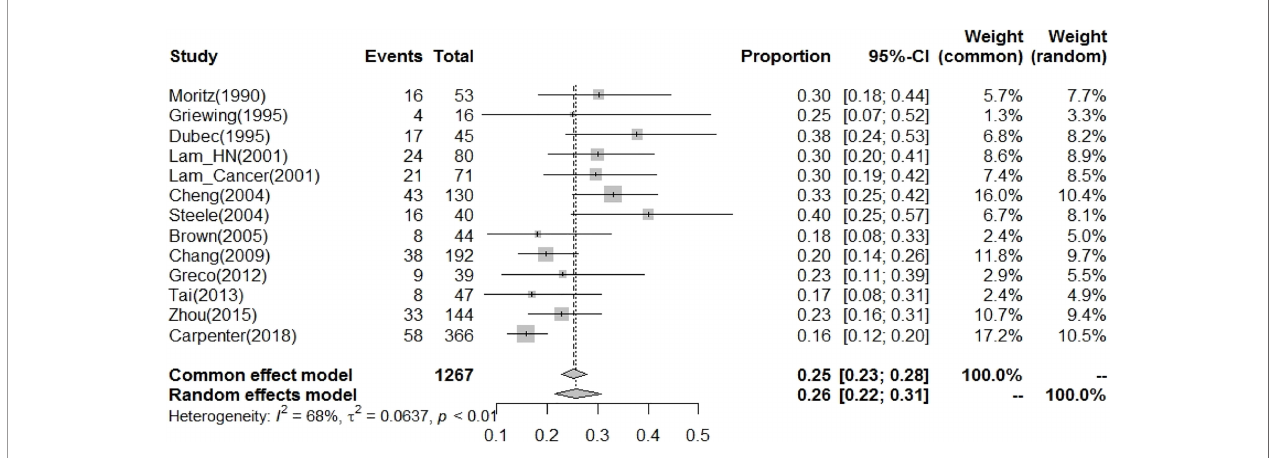
FIGURE 4 | The prevalence of CVD risk (CA stenosis>50% as increasing risk for CVD) for patients after radiotherapy to the neck was 26% (95% CI: